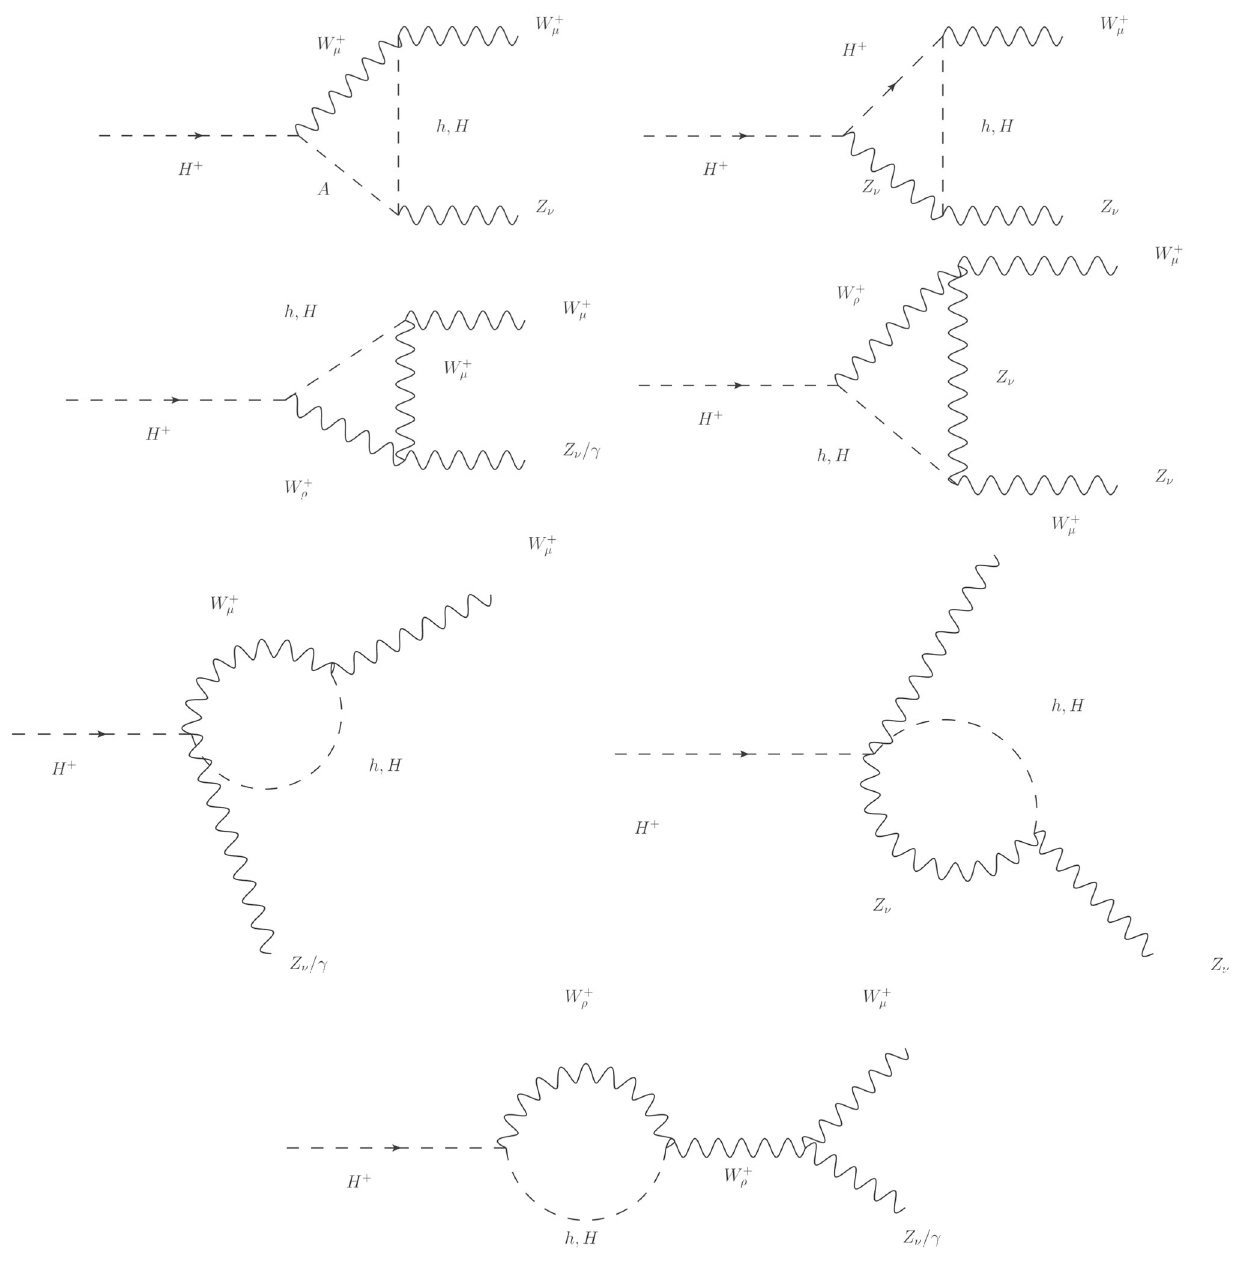
Fig. 6 Set C (cid:5) of one-loop amplitudes for 2HDM